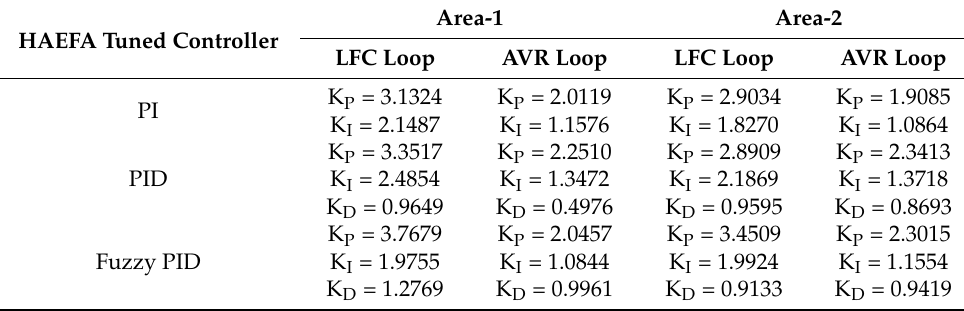
Table 4. Controller optimal gains found with HAEFA